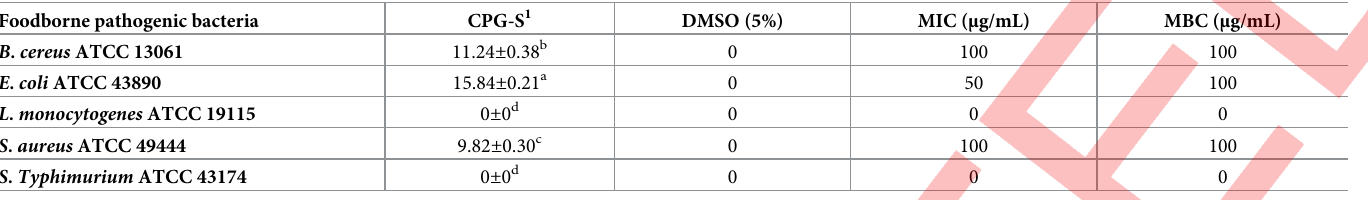
1) Data are expressed as the mean zone of inhibition in mm ± SD. Values with different superscript letters are significantly different at P < 0.05. DMSO was taken as the negative control.